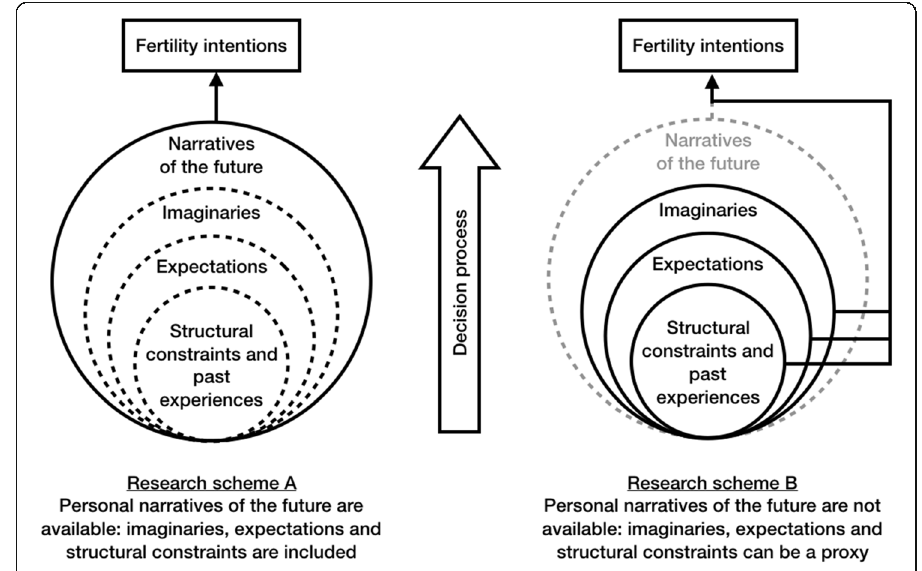
Fig. 2 Research schemes in the Narrative